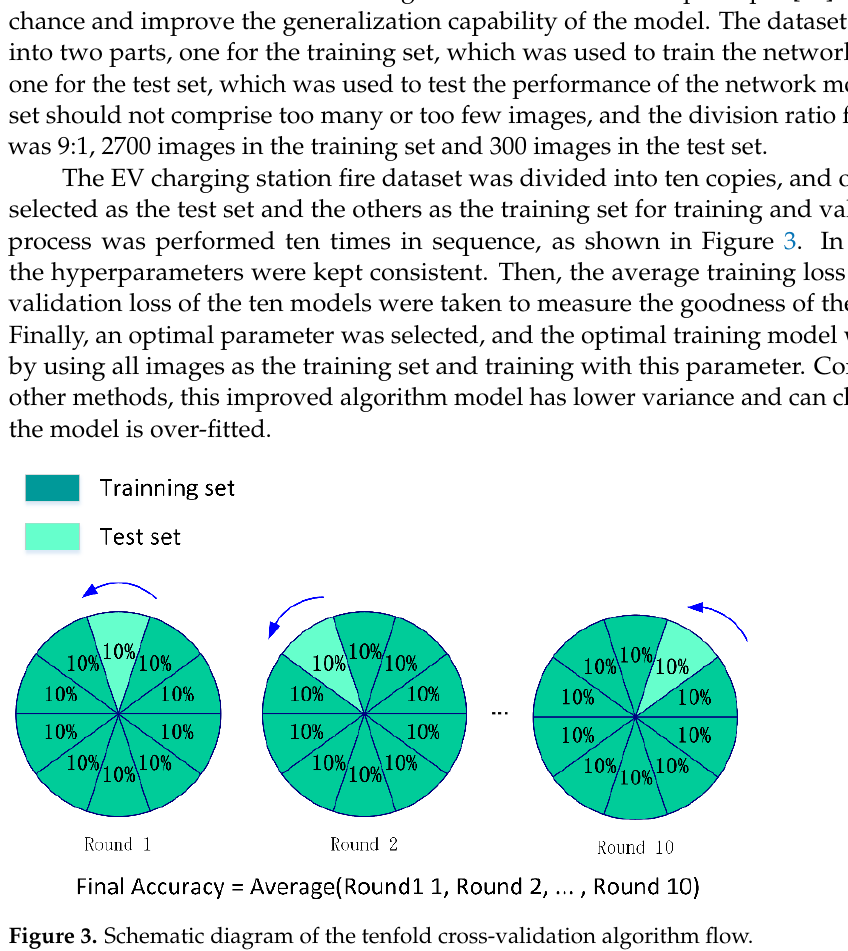
Table 2. Test results of different target detection algorithms on the COCO dataset.